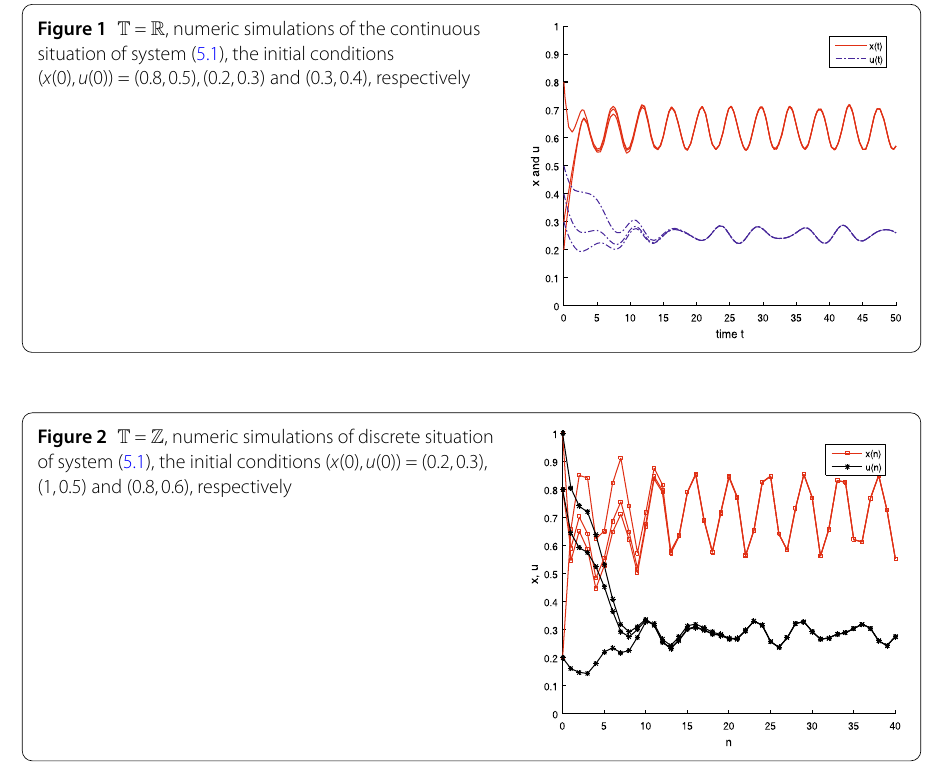
Figure 1 T = R , numeric simulations of the continuous situation of system (5.1), the initial conditions ( x (0), u (0)) = (0.8,0.5),(0.2,0.3) and (0.3,0.4), respectively